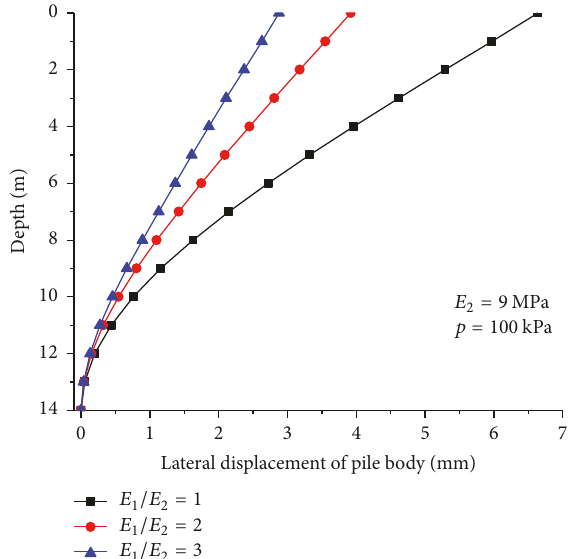
Figure 15: Lateral displacement of pile under coupling effect of stacking load and axial force.